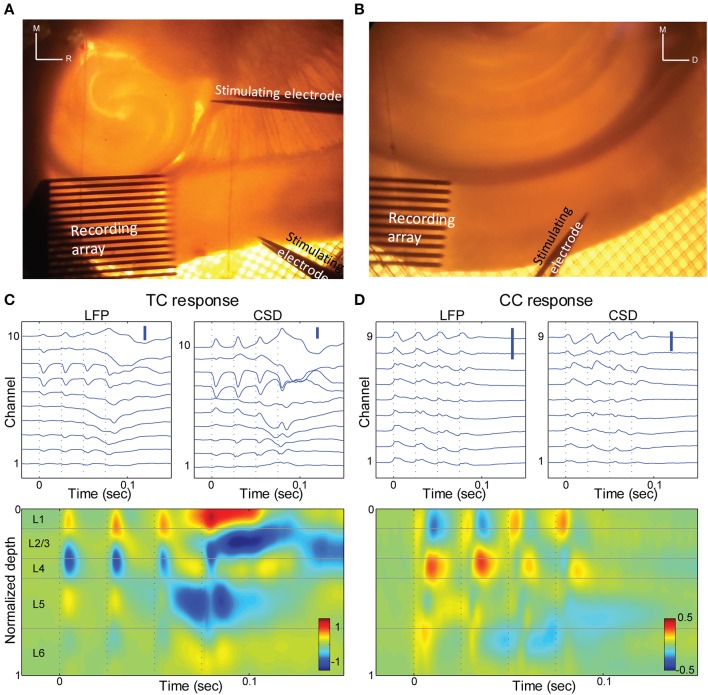
Thalamo-cortical and cortico-cortical responses in brain slices. (A) Photomicrograph of a TC slice. Recording array is in auditory cortex, and stimulating electrodes are in the TC afferent bundle and in layer 1 of a proximal cortical region. For scale reference, inter-electrode spacing in the recording array is 100 μm. (B) Photomicrograph of a coronal slice. Recording array is in auditory cortex, and stimulating electrodes in upper layer 5 of area V2. (C) LFP responses at different depths (top left) and derived CSD (top right; bottom) in response to a train of 4 × 40 Hz stimuli of the TC fibers. Same slice as in (A). Only electrodes that were in the cortex are shown and were used for further calculations. Scale bars 0.1 mV and 1 μA/mm3. (D) Similar to (C), but for stimulation of V2 in layer 5. Same slice as in (B) Scale bars 0.1 mV and 1 μA/mm3.